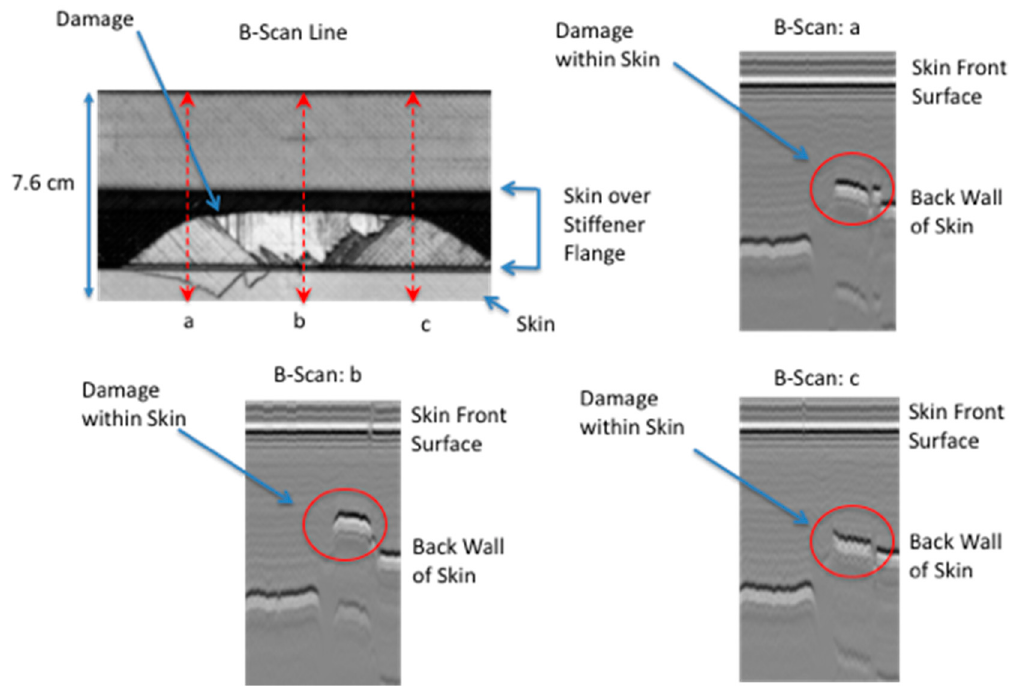
Figure 17. Ultrasonic data to estimate damage depth: ( a ) and ( c ) indicate damage one ply within skin; ( b ) indicate deeper damage two plies within skin.